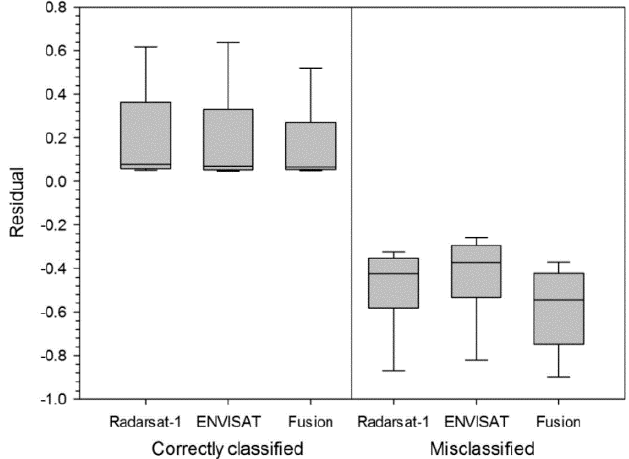
Figure 6. Box plots of residuals at correctly and incorrectly classified reference pixels.